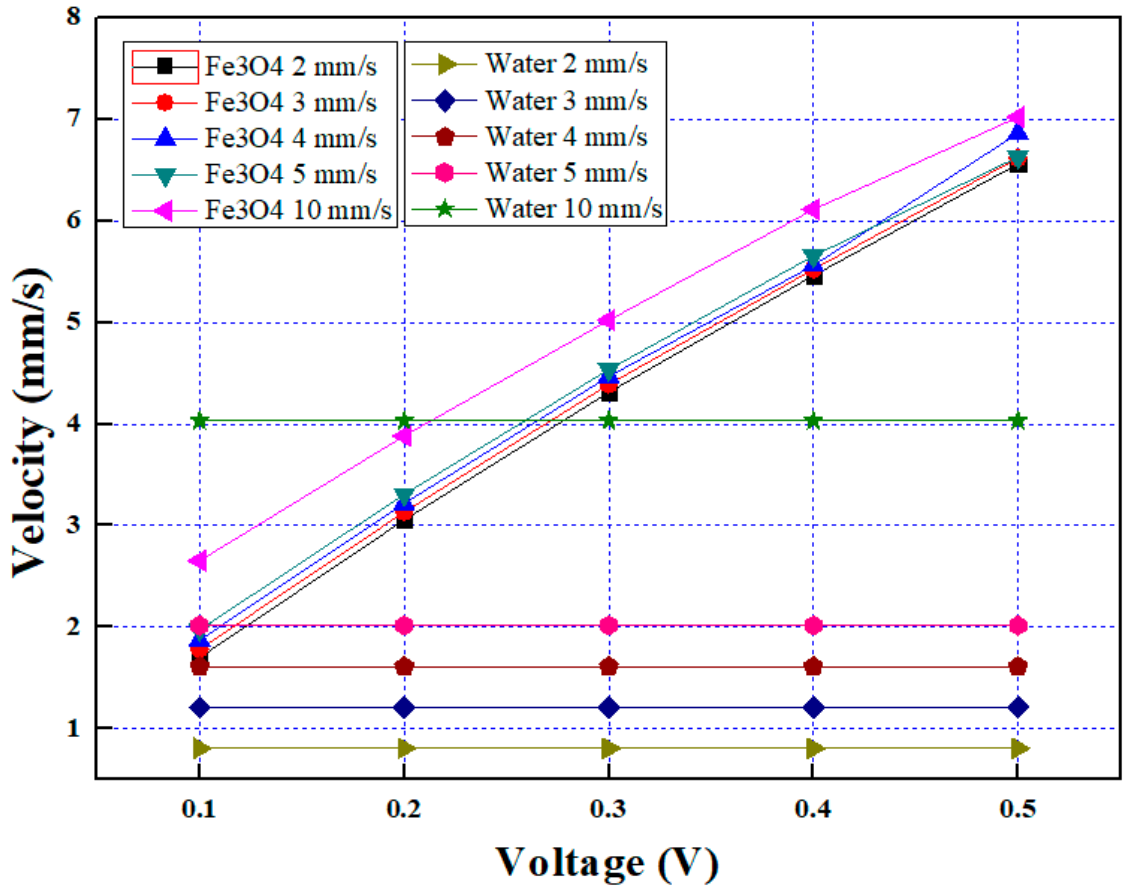
Figure 6. Outlet velocity comparison for water and ferrofluid cooling under the influence of inlet velocity and voltage.